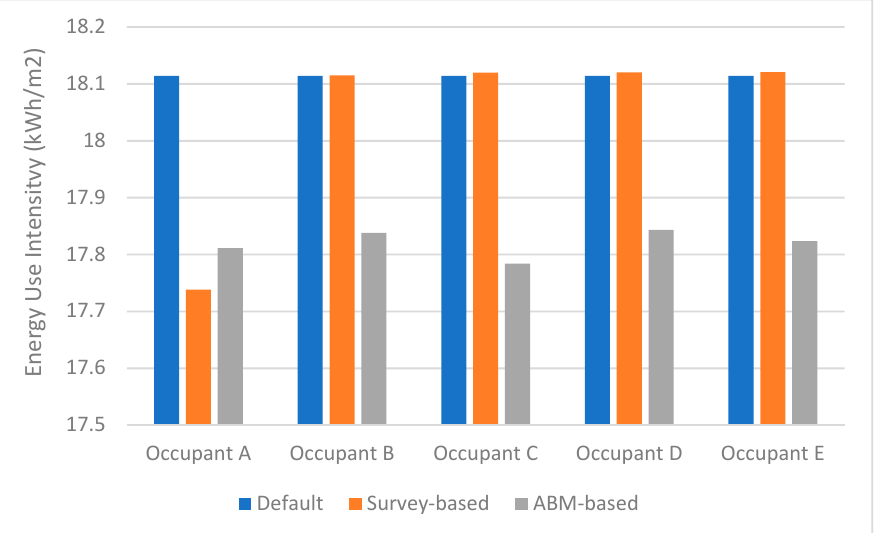
Figure 7. Energy use intensity comparison at the building level. Table 3. End uses of case study